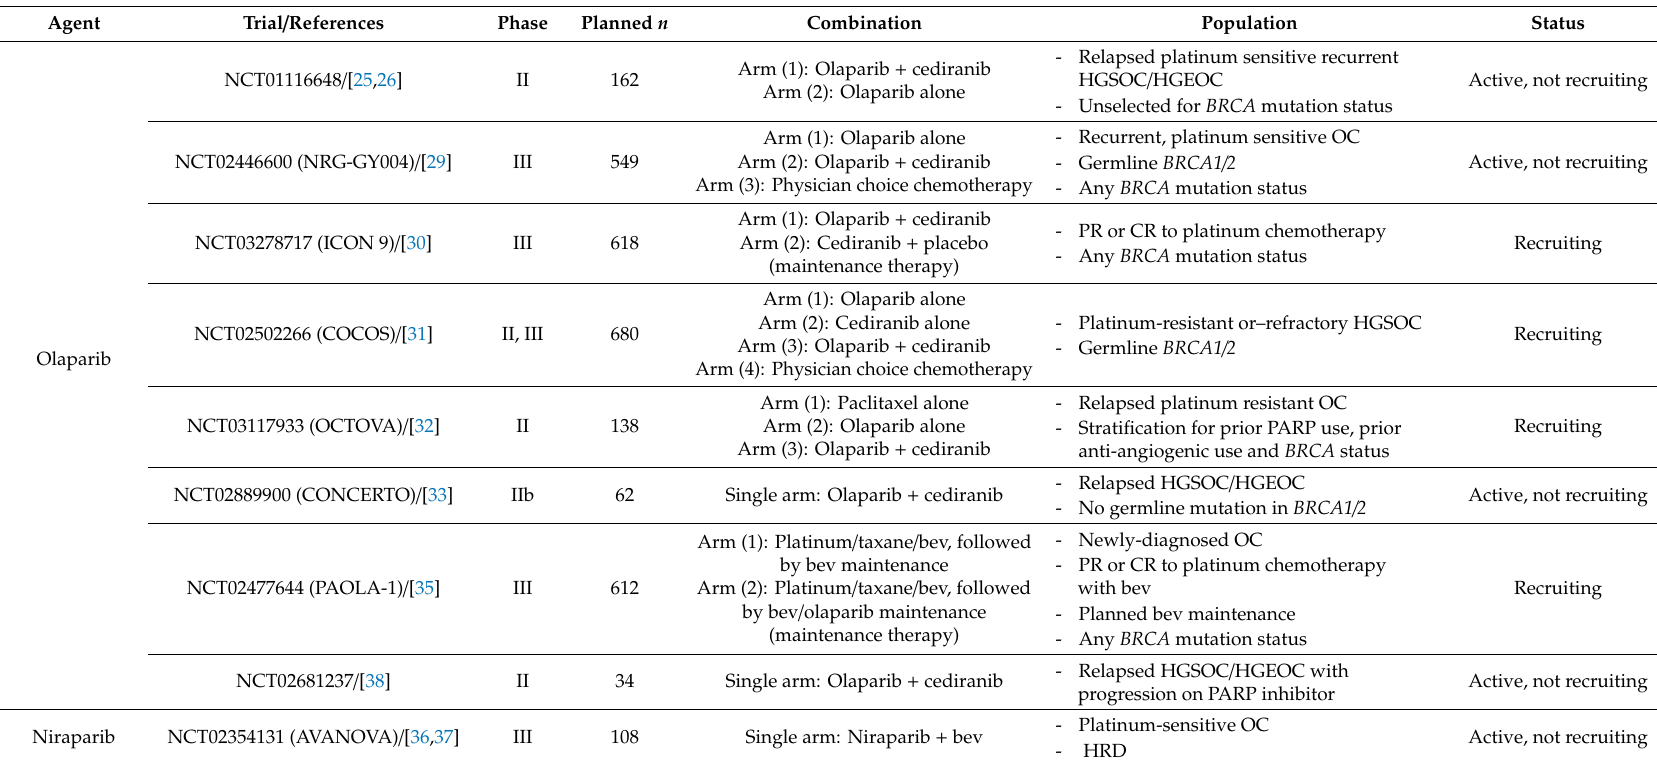
Table 1. Ongoing combination trials with PARP inhibitors and antiangiogenic agents